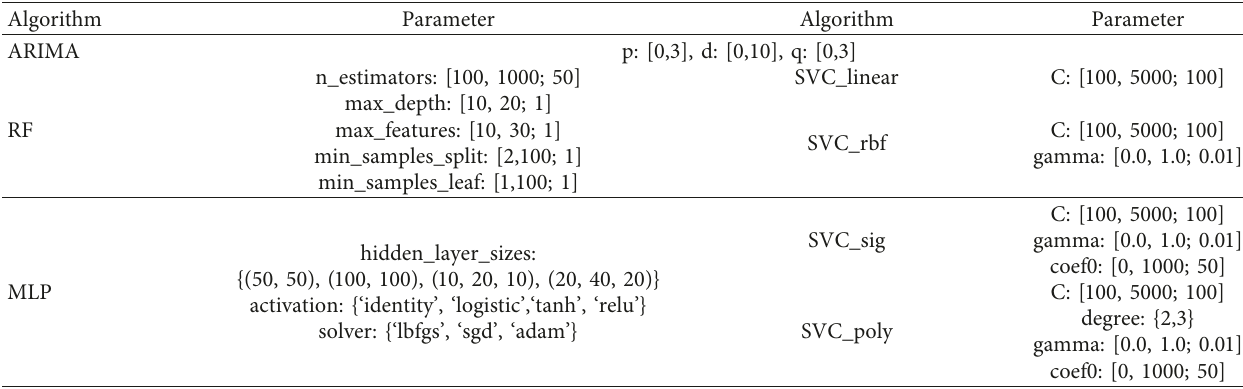
Table 5: Main parameters and their tuning range of the used algorithms. Algorithm Parameter Algorithm Parameter